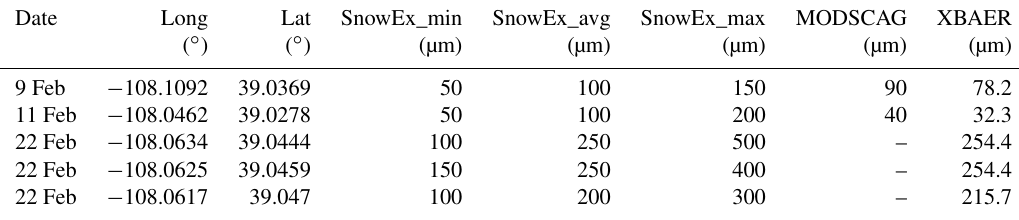
Table 4. The comparison between SnowEx SGS measurements, XBAER- and MODSCAG-retrieved SGS during February 2017.